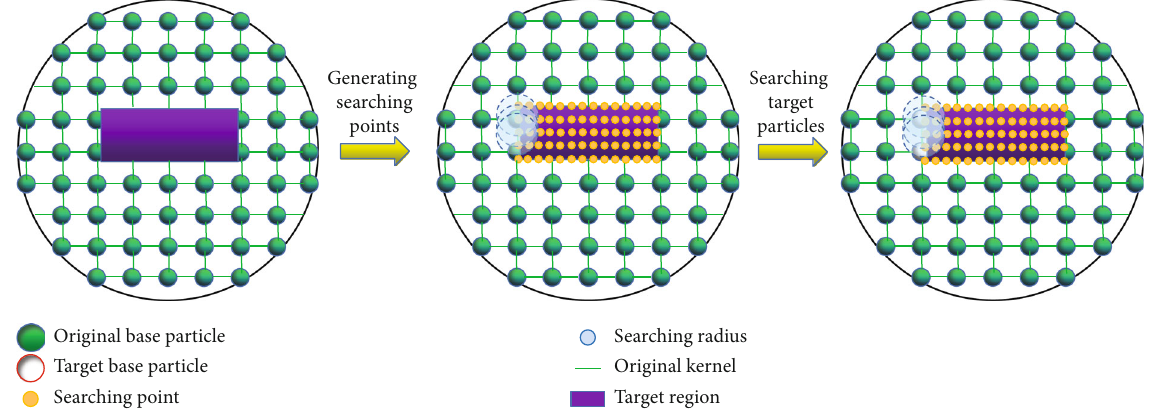
Figure 4: Killing particle